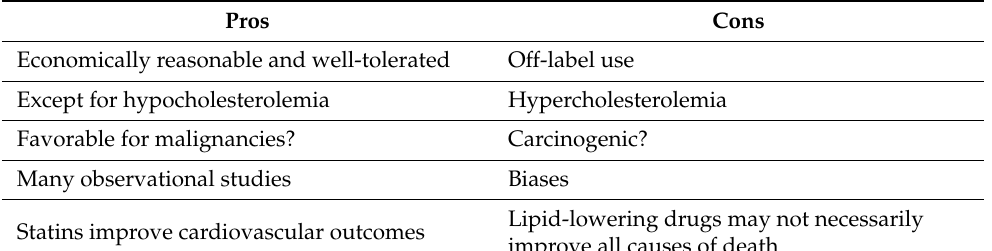
Table 2. Pros and cons of statin use for patients with malignant tumors.